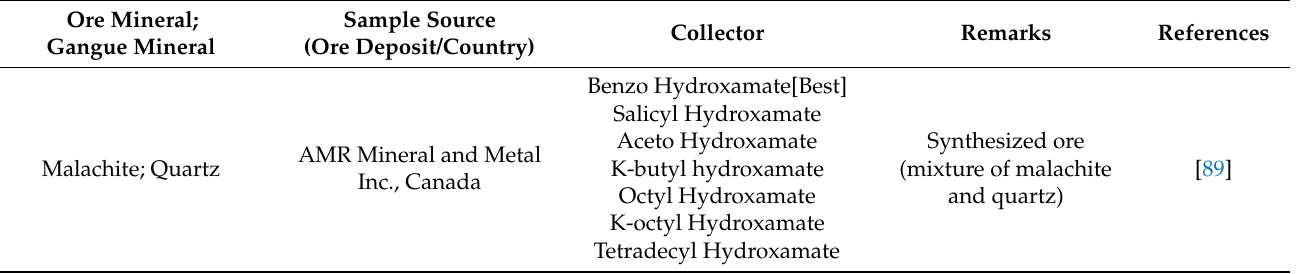
Table 8. Surfactants for copper oxide